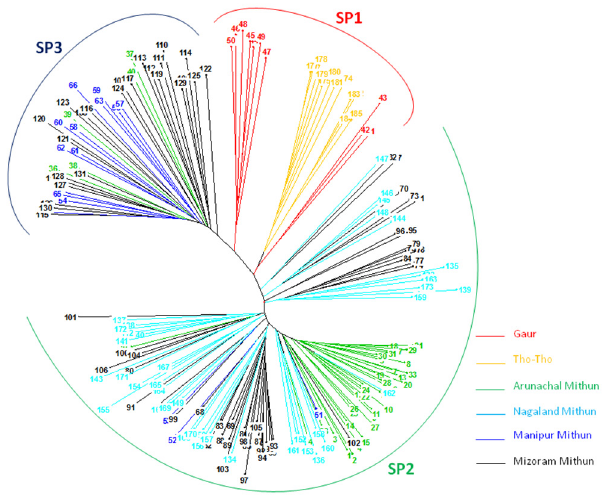
Figure 3. Unweighted and unrooted neighbor-joining cluster analysis. SP1 = Gaur and Tho-tho samples; SP2 = Arunchal and Nagaland mithun samples; SP3 = Manipur and Mizoram mithun samples.